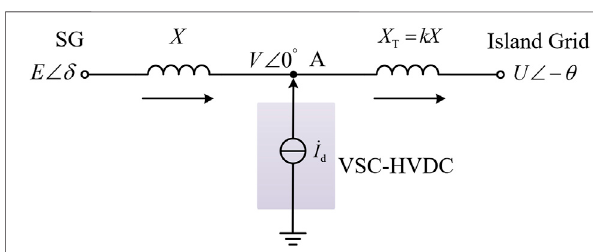
FIGURE 2 | Simpli fi ed system